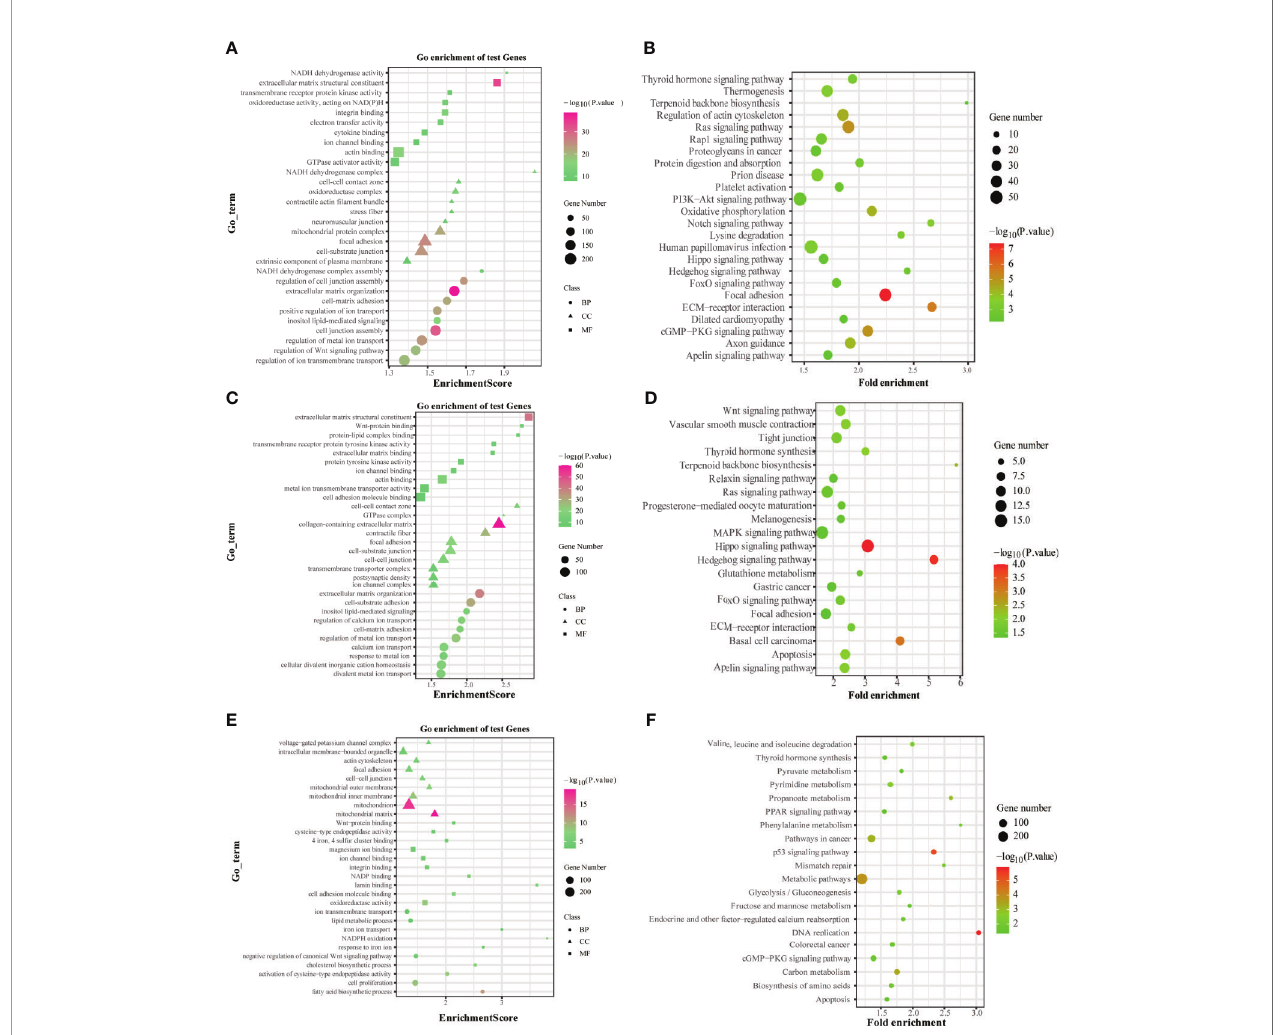
FIGURE 8 | GO and KEGG analyses of the DEGs between the high-risk and low-risk groups in the TCGA (A, B) , ICGC (C, D) and GSE39582 (E, F)